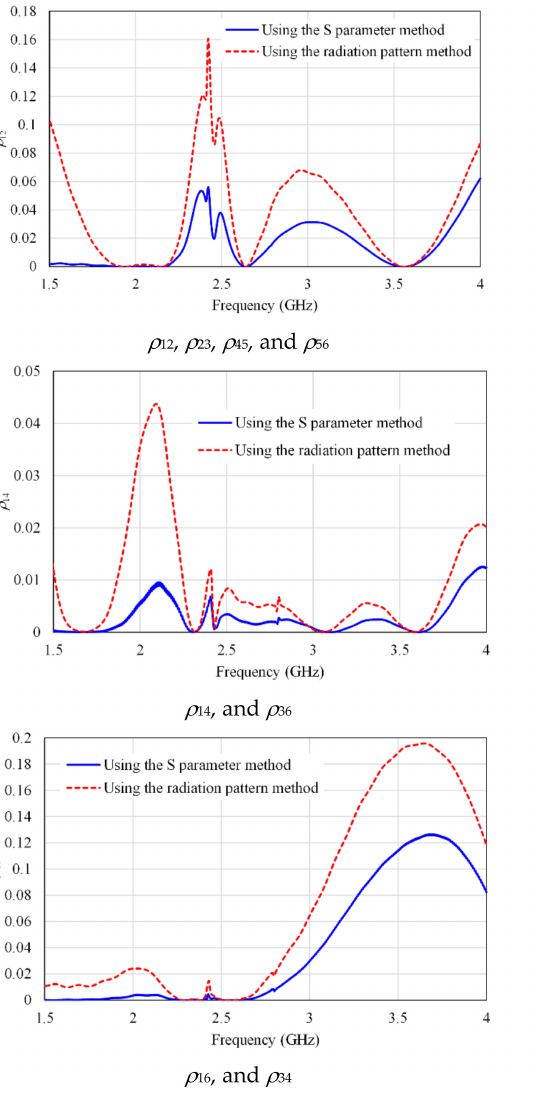
Figure 16. The ECC of the proposed MIMO antenna using the S parameter and radiation pattern